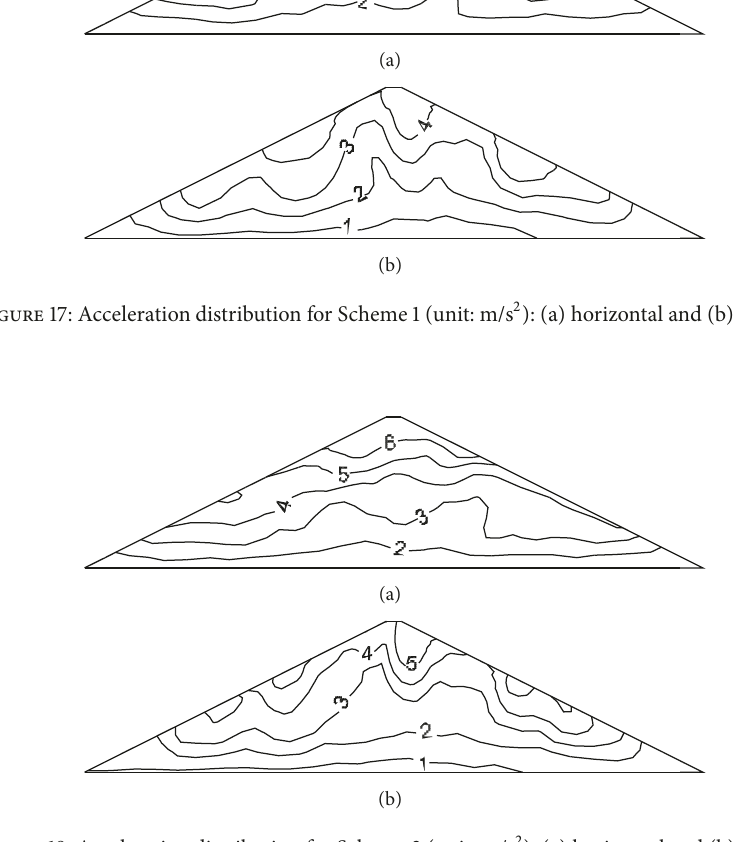
Figure 18: Acceleration distribution for Scheme 2 (unit: m/s 2 ): (a) horizontal and (b) vertical.